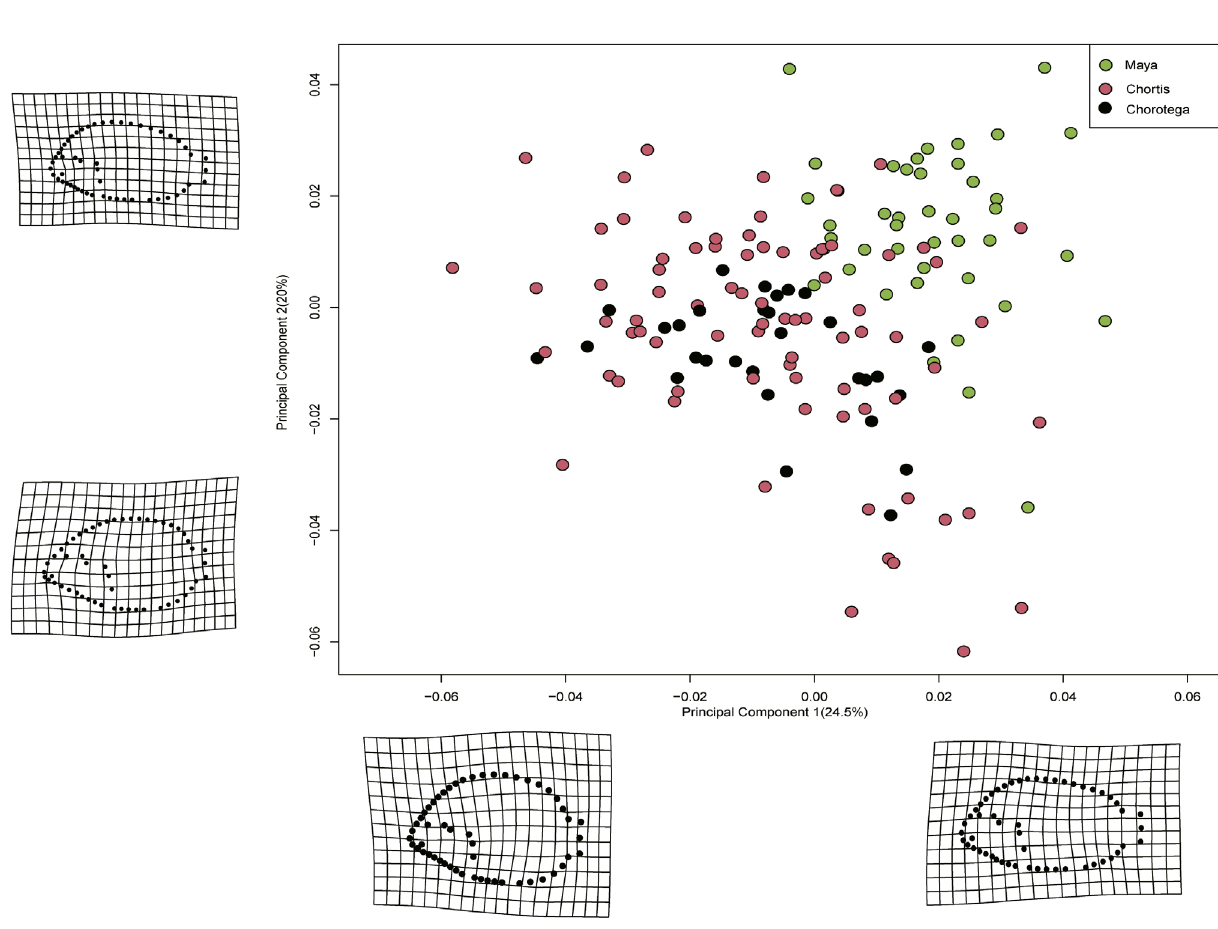
FIGURE 3 | Principal component analysis of size-corrected shape and deformation grids along each axis.